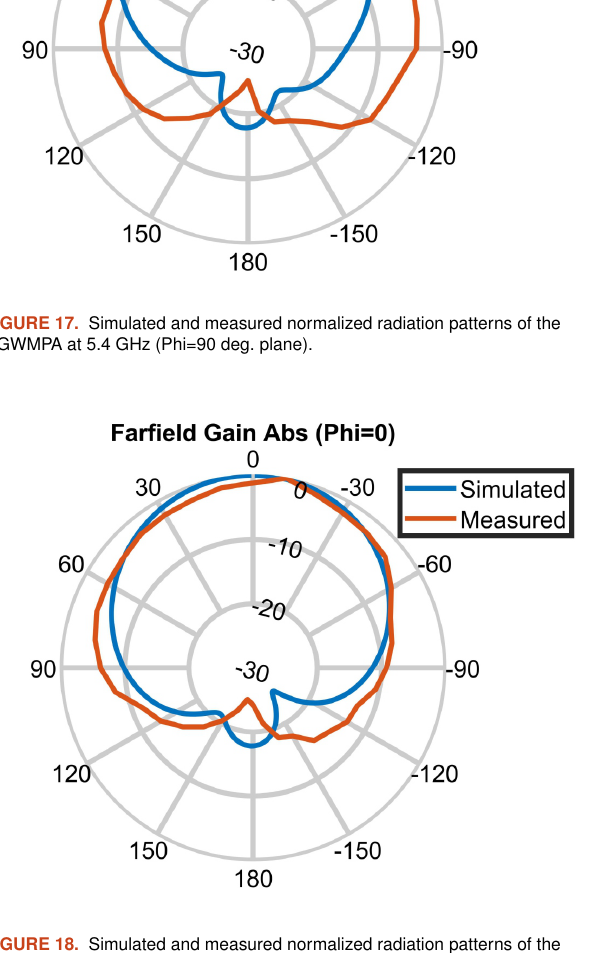
FIGURE 18. Simulated and measured normalized radiation patterns of the HGWMPA at 5.4 GHz (Phi=0 deg.